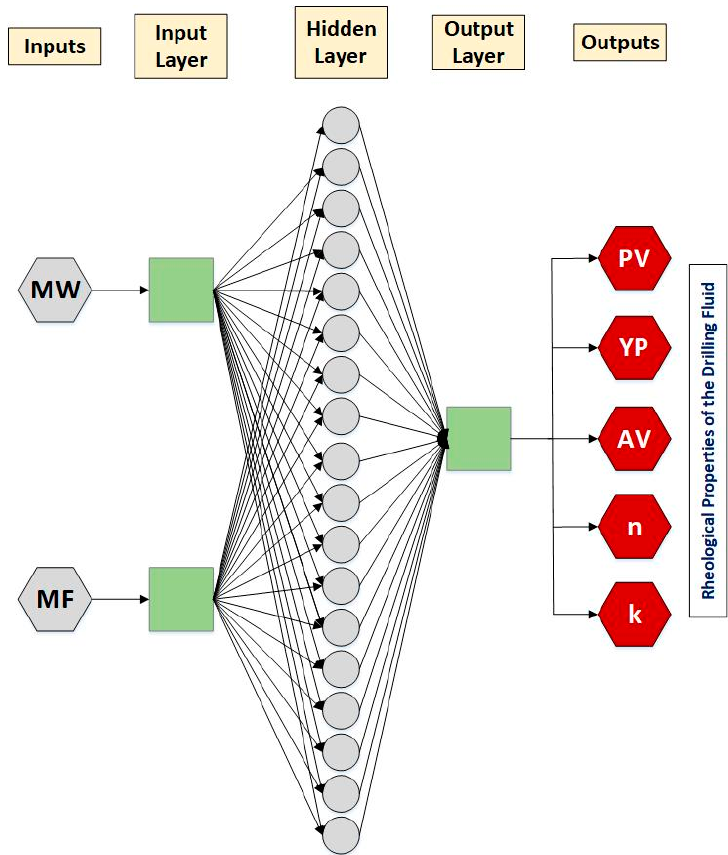
Figure 2. Typical schematic for the architecture of the developed ANN models .